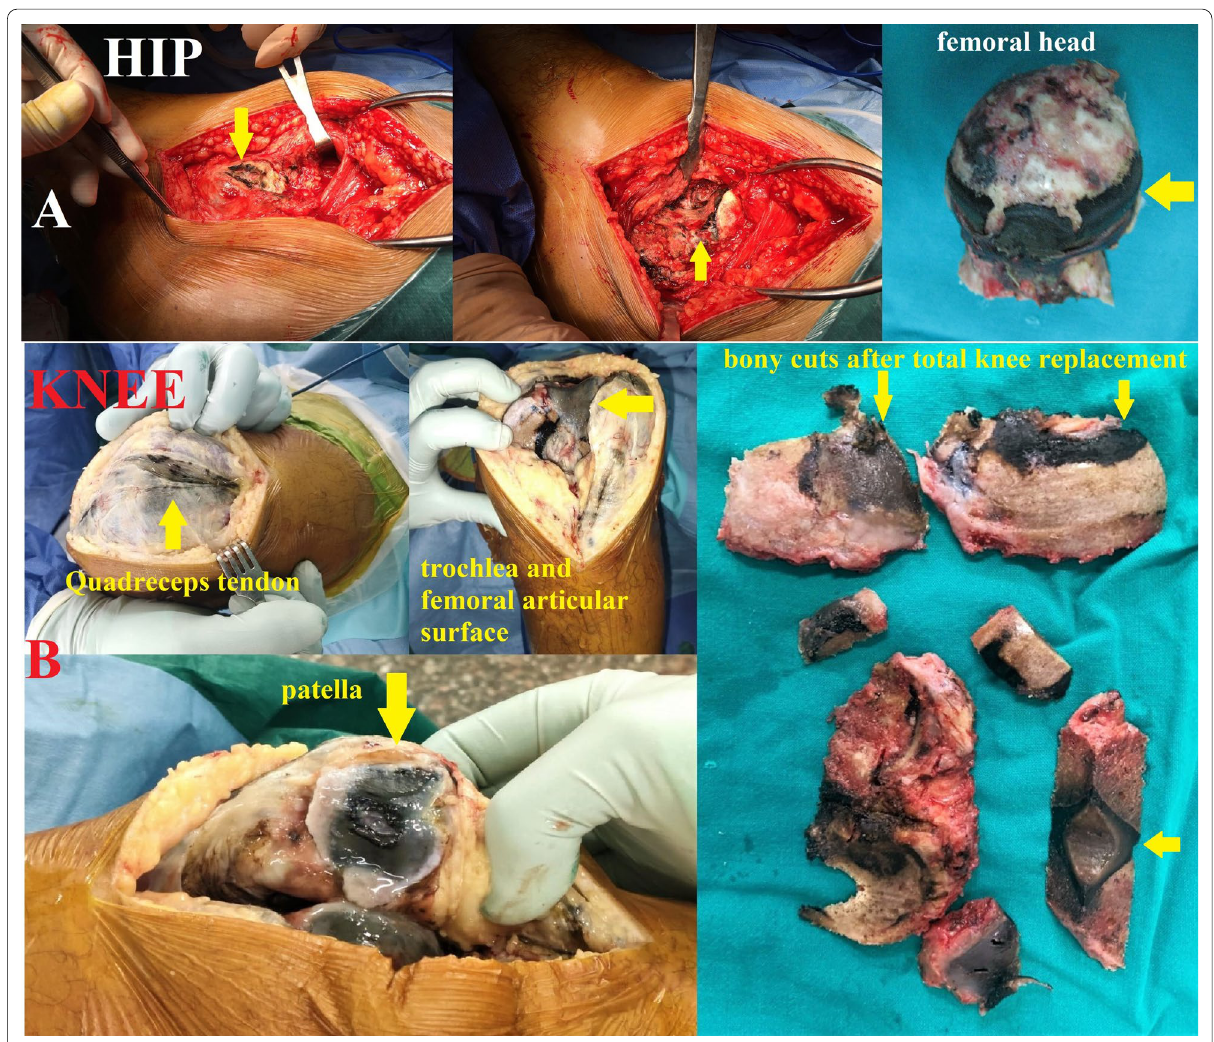
Fig. 4 Intraoperative clinical images of A hip, and B knee showing a blackish discoloration of soft tissues and articular surface indicated by yellow